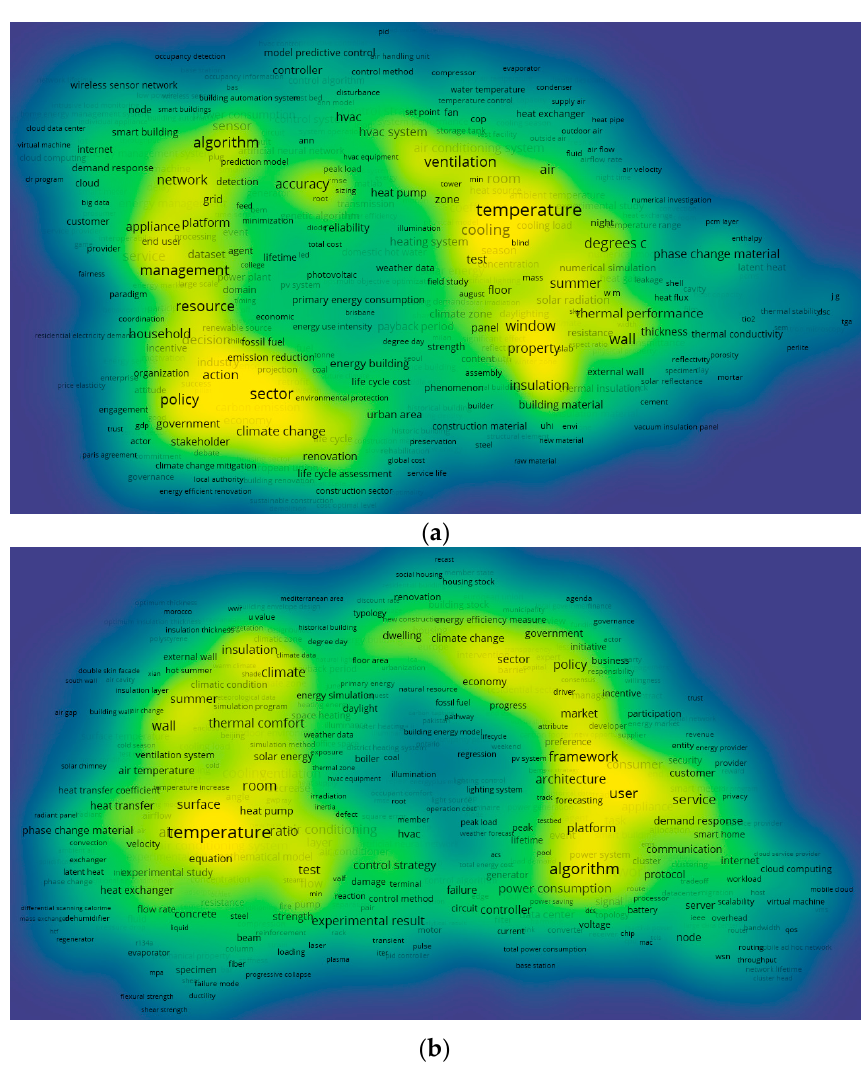
Figure 13. Density visualization of word occurrence at title and abstract level in ( a ) Web of Science and ( b )